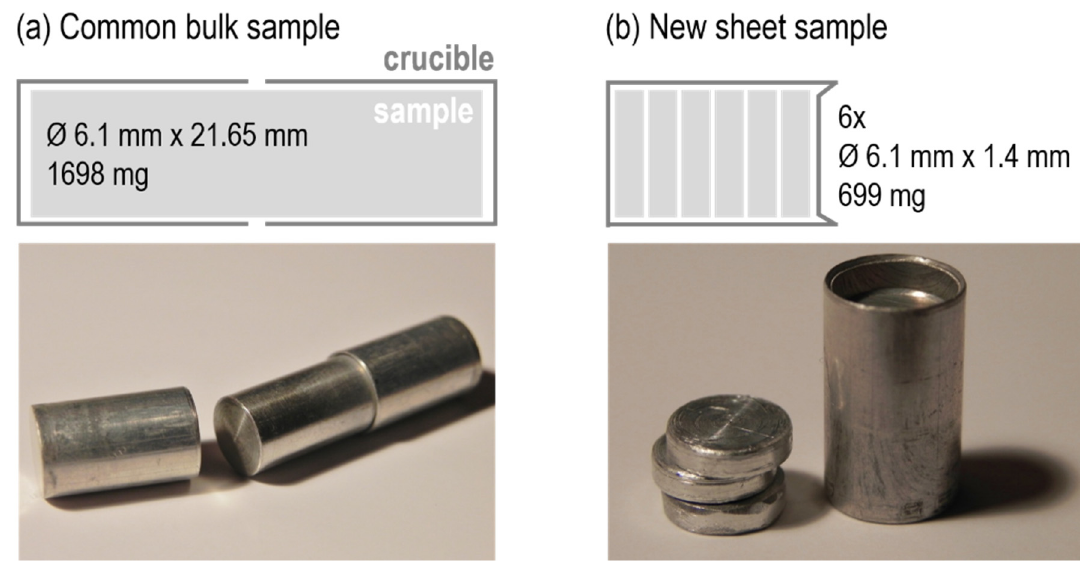
Figure 1. Schematics for the used common ( a ) and new sheet ( b ) sample with dimensions and masses as well as pictures of EN AW-6005A samples with